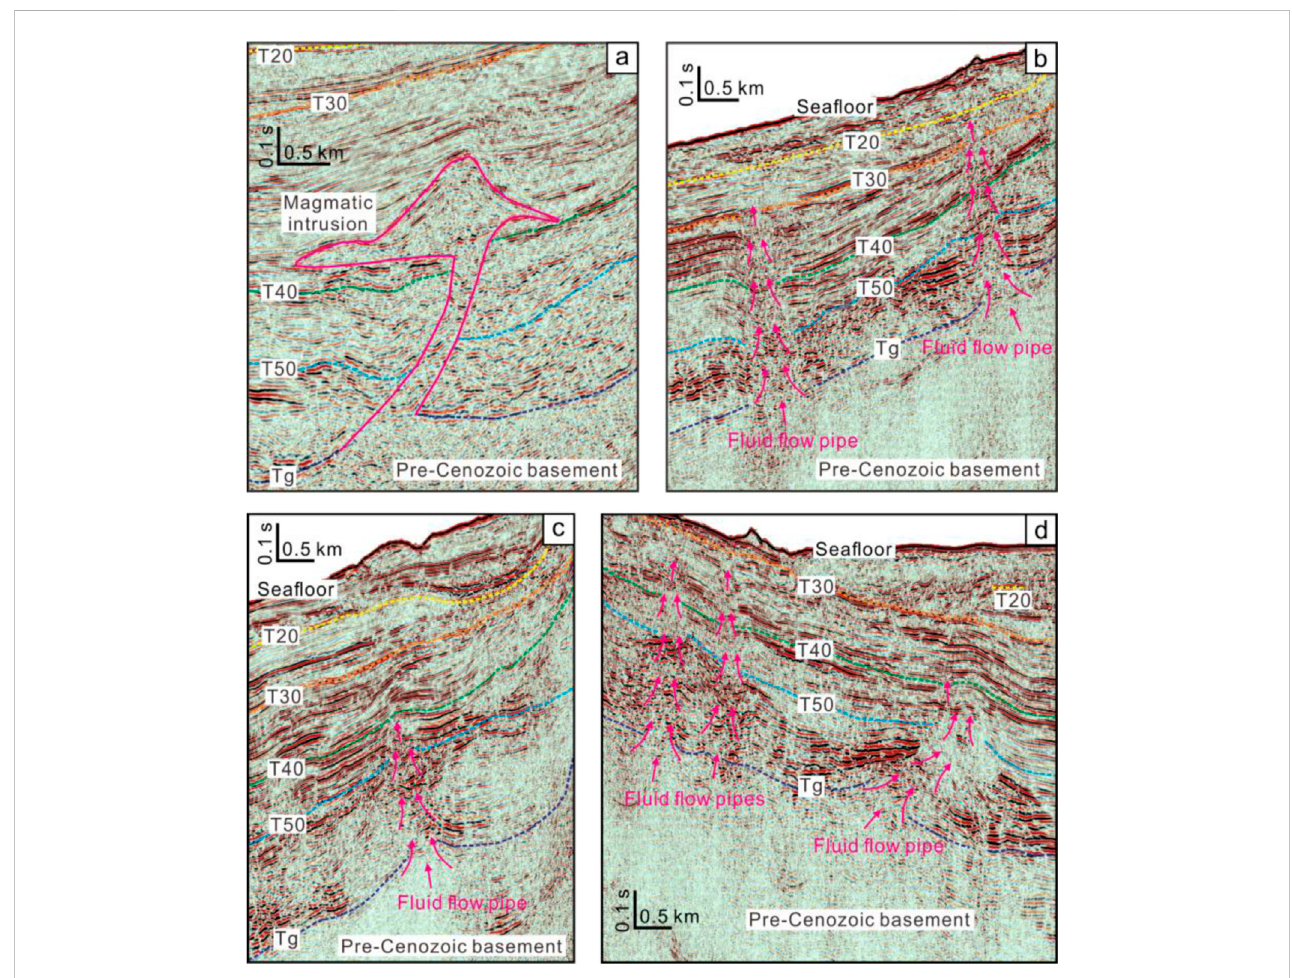
FIGURE 7 Detailed images of magmatic intrusion (A) and fl uid fl ow pipes (B-D) . See Figures 3 – 5 for locations. Carmine line represents the con fi guration of a magmatic intrusion and the arrows represent the migrated directions of fl uid fl ows. T20, T30, T40, T50, Tg: seismic re fl ectors. The depth was two-way travel